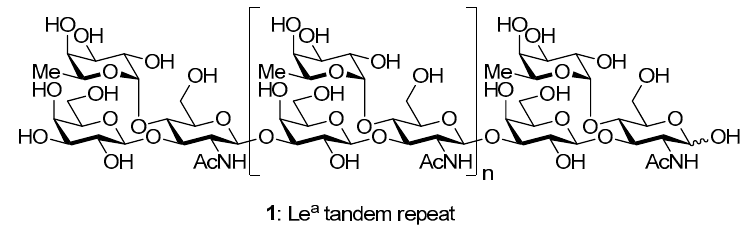
Figure 1. Structure of the Le a tandem repeat.